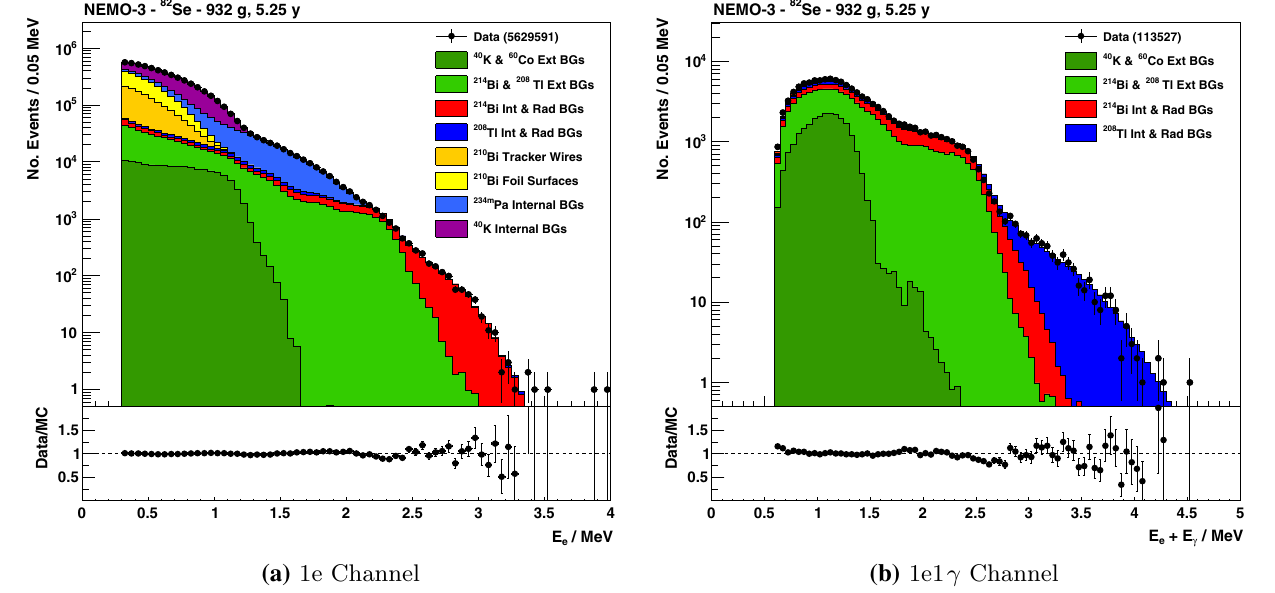
Fig. 4 a Energy spectrum of electrons in events containing a single electron selected in the 1e channel compared to the MC prediction. At energies below 1MeV the dominant contributions are from 40 K con- tamination and from 210 Bi deposited on the surfaces of the source foils and tracker wires. The contribution from 234m Pa becomes significant in an intermediate region at 1.2–2.2MeV. Above this energy the spec- trum is composed of events from 214 Bi originating from source foil contamination and radon backgrounds. The small numbers of events at